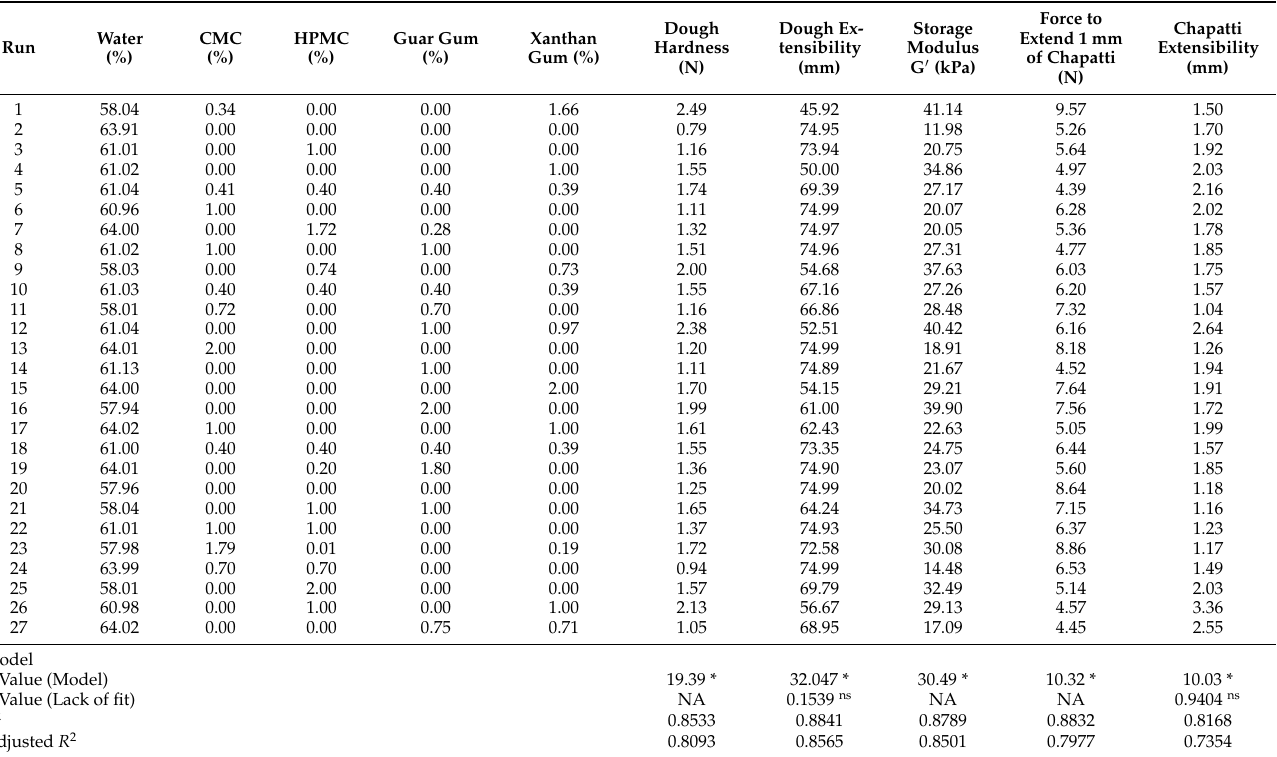
Table 2. Rheological and textural characteristics of dough and baked chapatti containing 10% cricket flour as influenced by water, CMC, HPMC, guar gum and xanthan